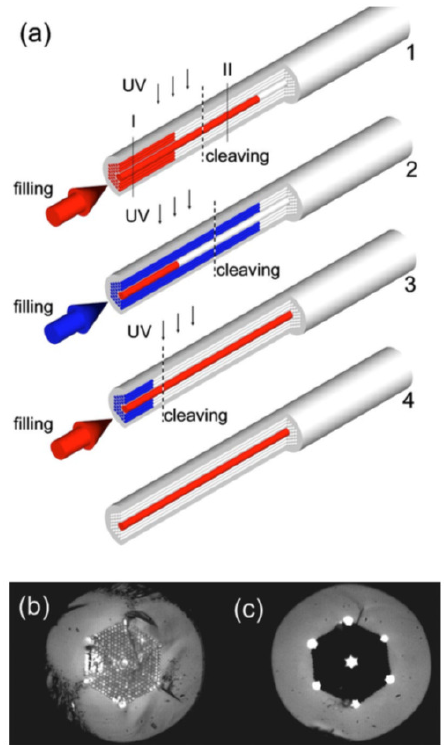
Figure 4. ( a ) Schematic flowchart on selective filling of photonic crystal fibers. The images ( b , c ) are optical microscope images of the fiber cross sections at the cleave positions I and II. The light regions correspond to the holes filled with polymer, reprinted with permission from